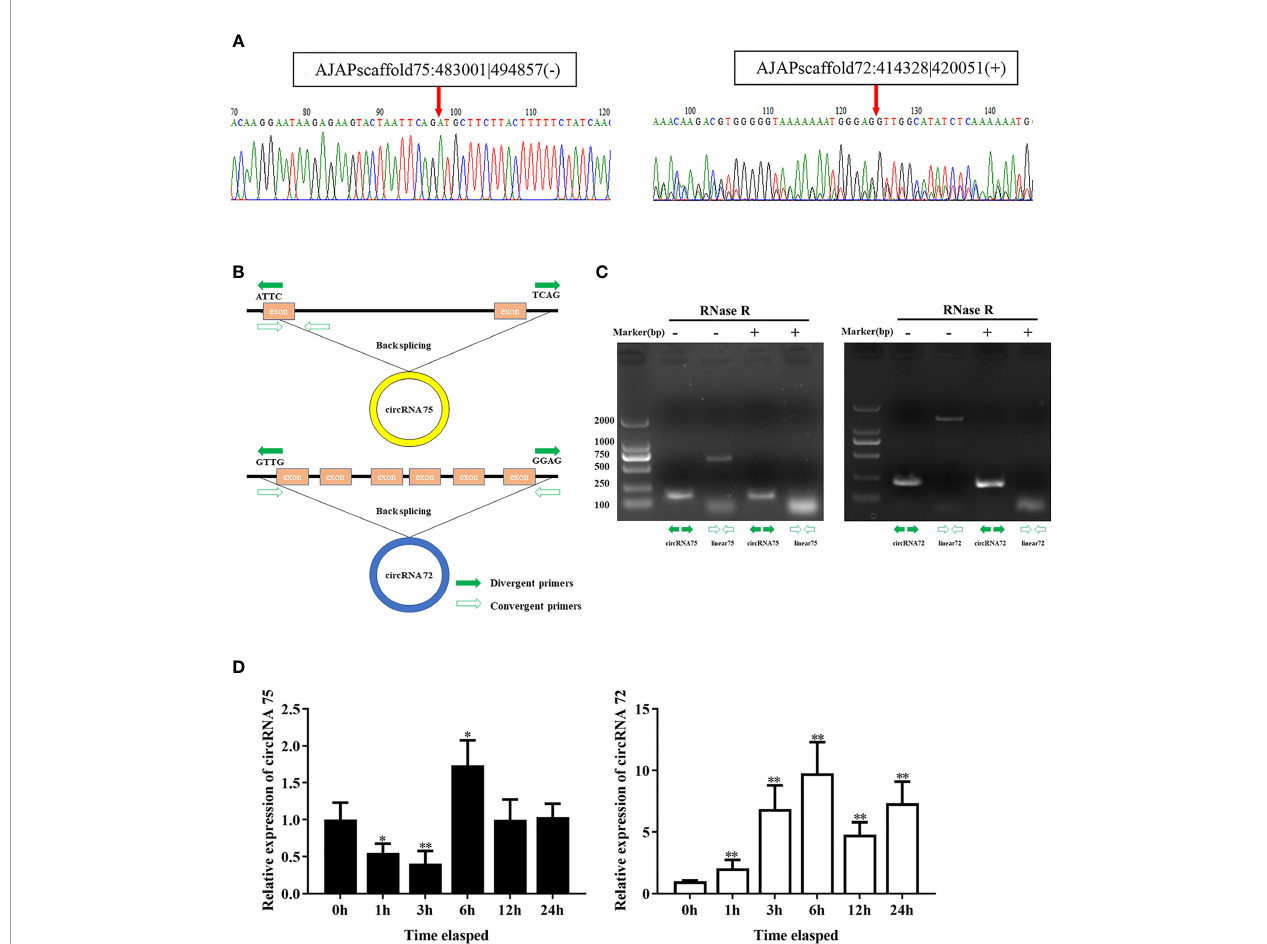
FIGURE 1 | Identi fi cation of the two circRNAs related to SUS development. (A) The back-splicing junctions of circRNA75 and circRNA72 were veri fi ed by RT-PCR and Sanger sequencing, respectively. (B) Schematic illustration exhibited the formation of the two circRNAs through the circularization of their host genes. (C) Relative expressions of circRNAs and linear RNA in coelomocytes were detected by RT-PCR upon RNase R treatment. (D) The expression patterns of circRNA75 and circRNA72 under LPS stimulation. *p < 0.05 and **p <